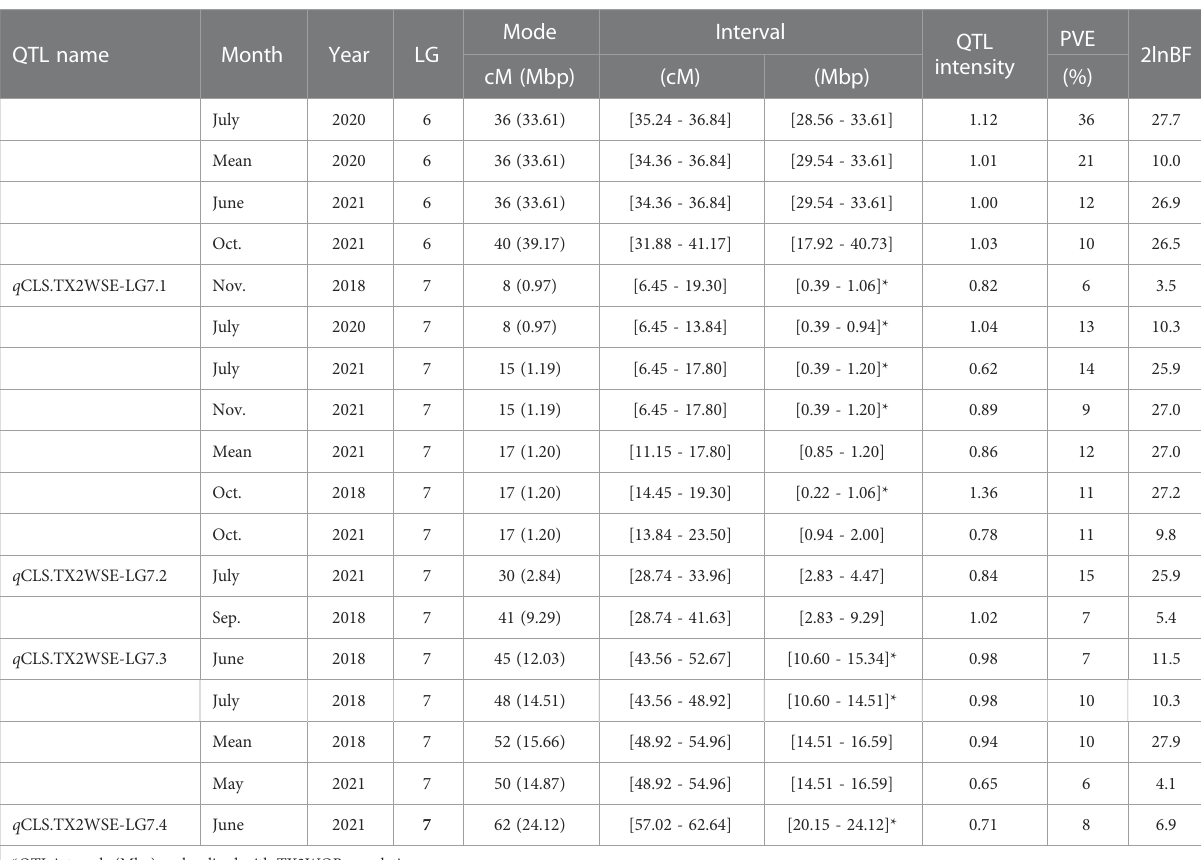
data sets over the three evaluated years, respectively, with high 2lnBF and PVE values. Hence, these QTLs passed our inclusion threshold and underwent downstream analysis. out of 20 evaluated data sets with either strong or decisive evidence and PVE up to 25%. The intervals of this QTL were variable and overlapped between 0 to 18.39 cM (15.4 to 27.8 Mbp) in six data sets, 16.31 to 18.39 cM (21.5 to 27.8 Mbp) over eight environments (Table 2, Supplementary Table 11, and Figure